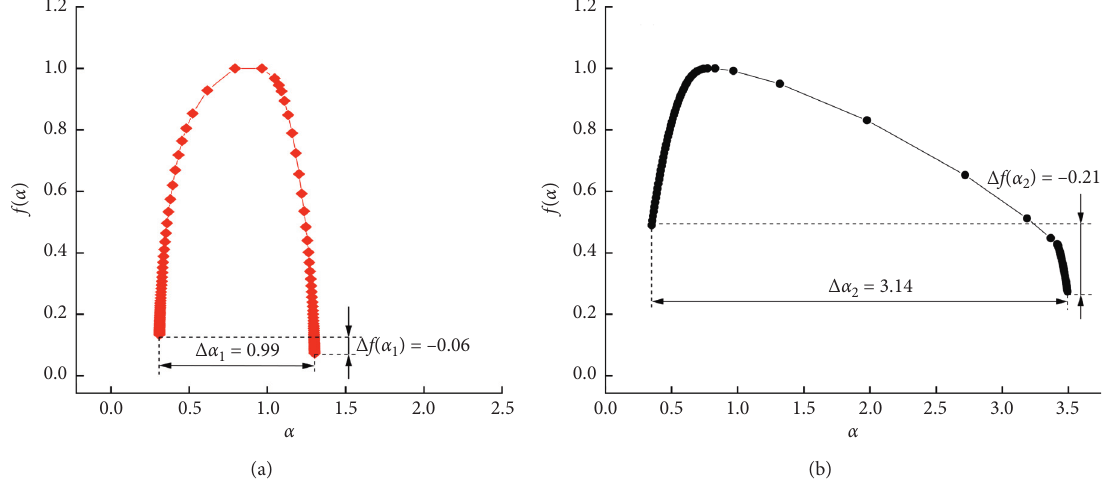
Figure 11: Multifractal spectrum of typical signal: (a) MS signal; (b) blasting